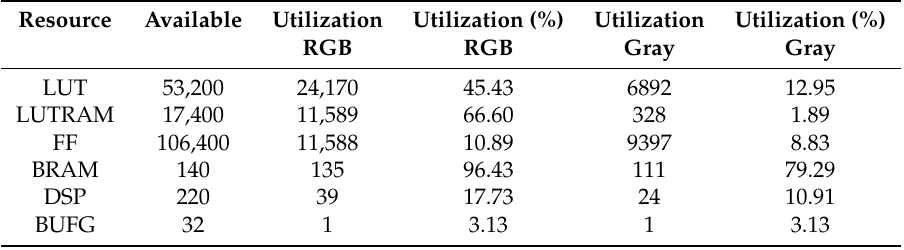
Table 10. FPGA resources utilization (in number of